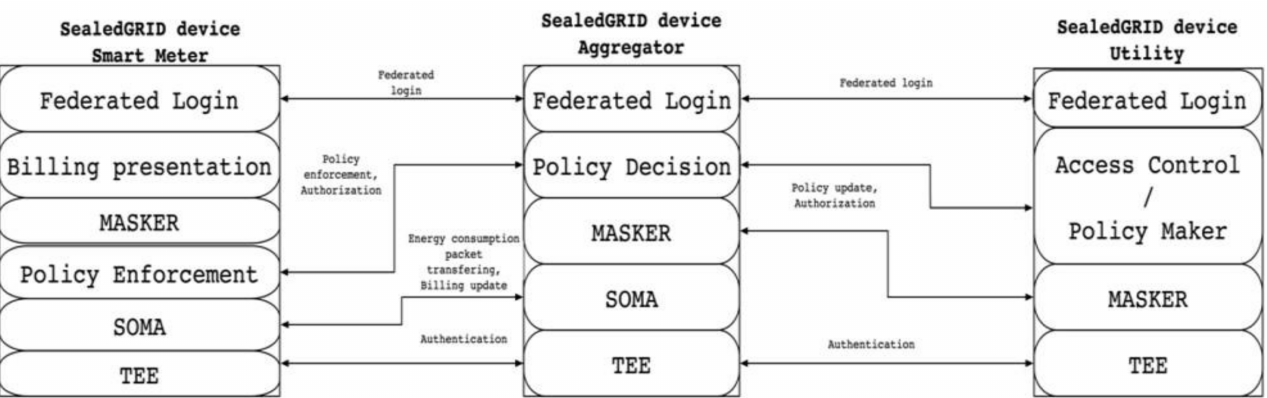
Figure 2. SealedGRID components and their functions.